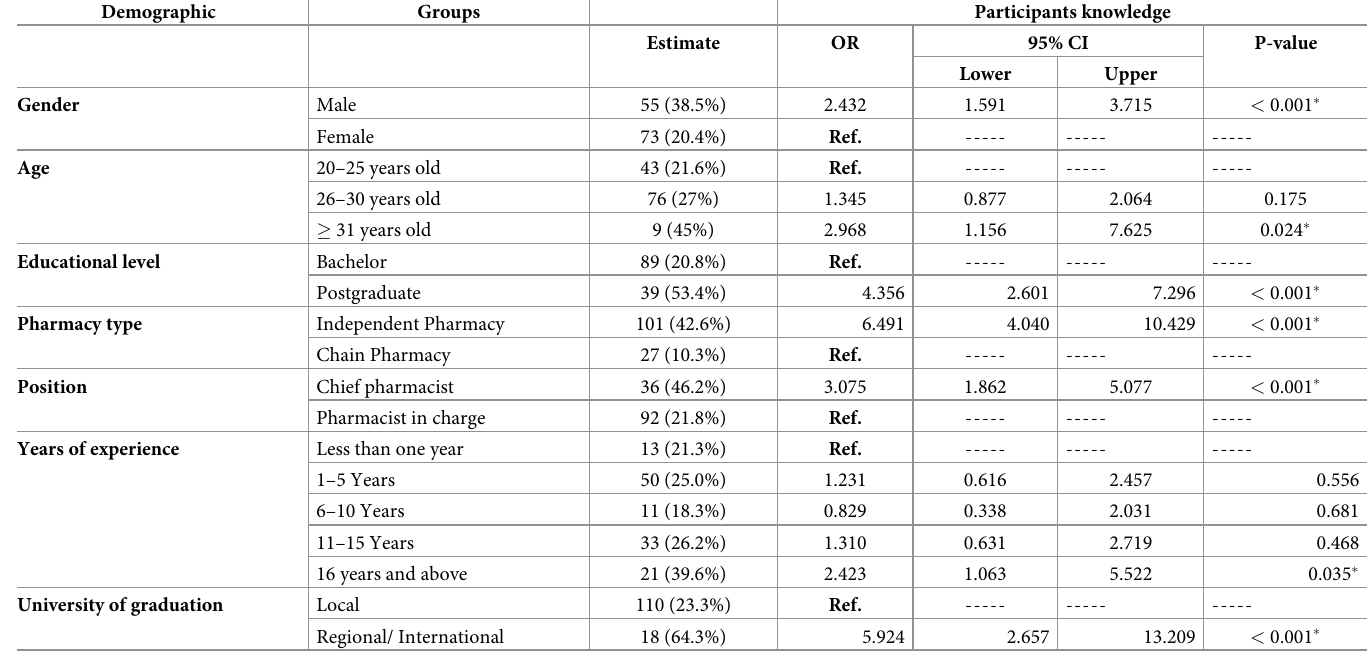
Table 2. Participants’ knowledge according to demographic